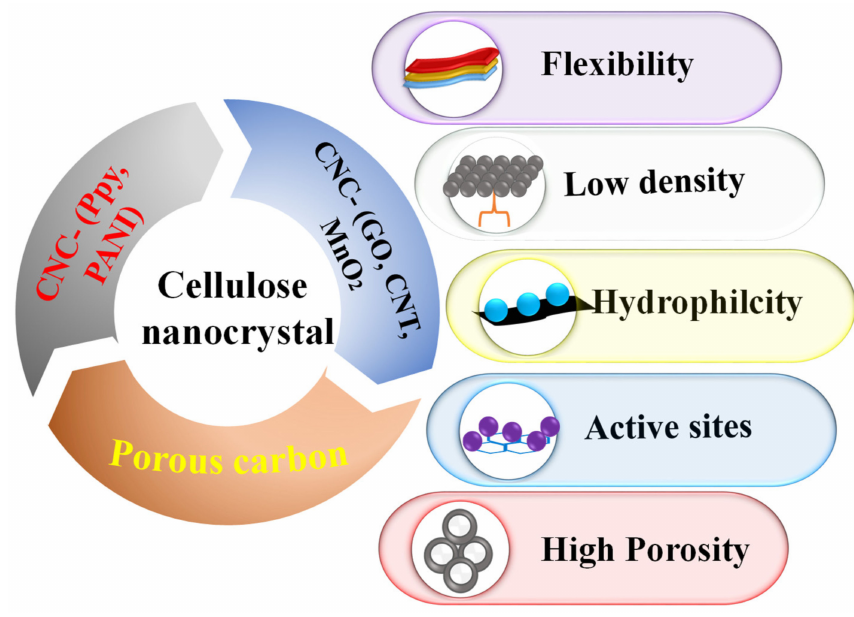
Figure 1. Schematic illustration of the hybrid cellulose nanocrystal and its